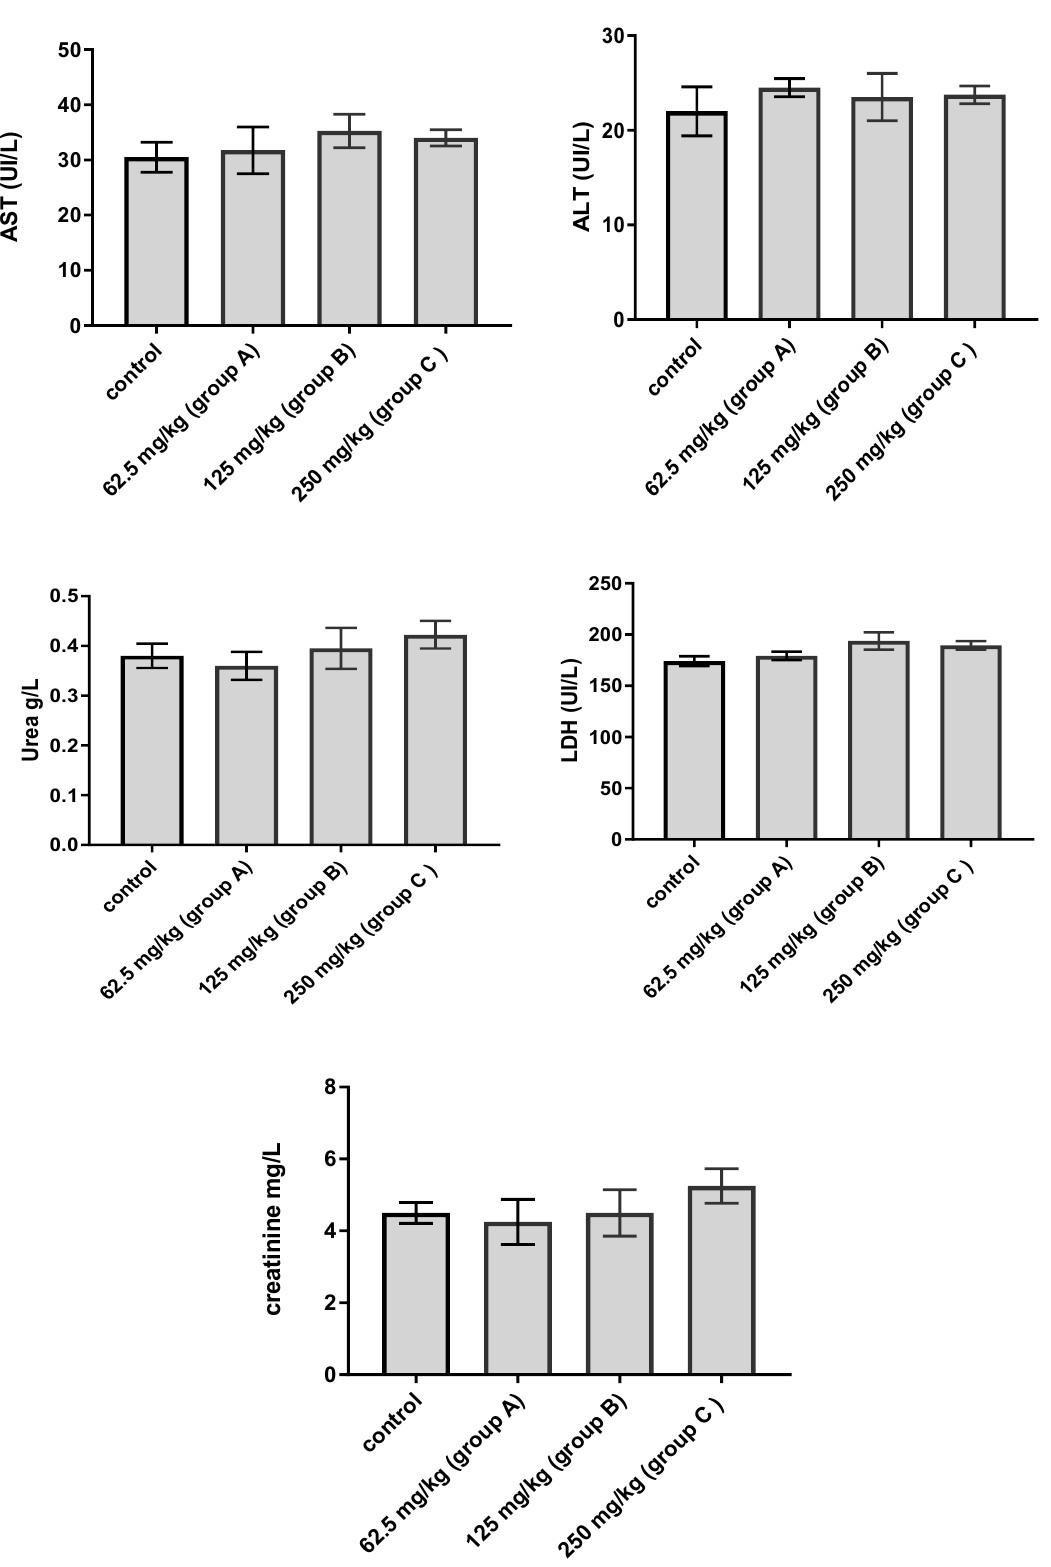
Figure 3 : The effect of the oral administration of aqueous extract of B. dioica roots on AST, ALT, creatinine, urea, and LDH of treated mice, results as the mean ± SD (standard deviation).